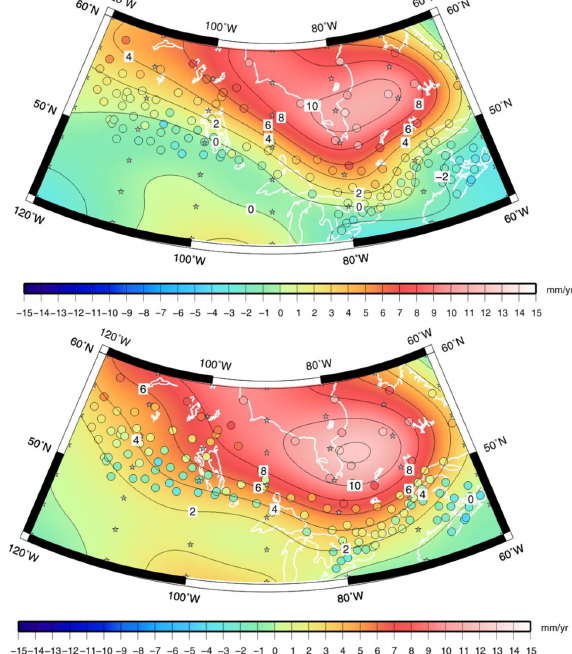
Figure 6. Upper plot: Combined GRACE and GNSS vertical dis- placement rates; unit is mm/yr; Lower plot: GRACE CSR RL 04 vertical displacement rates overlaid with CBN verti- cal velocities; unit is